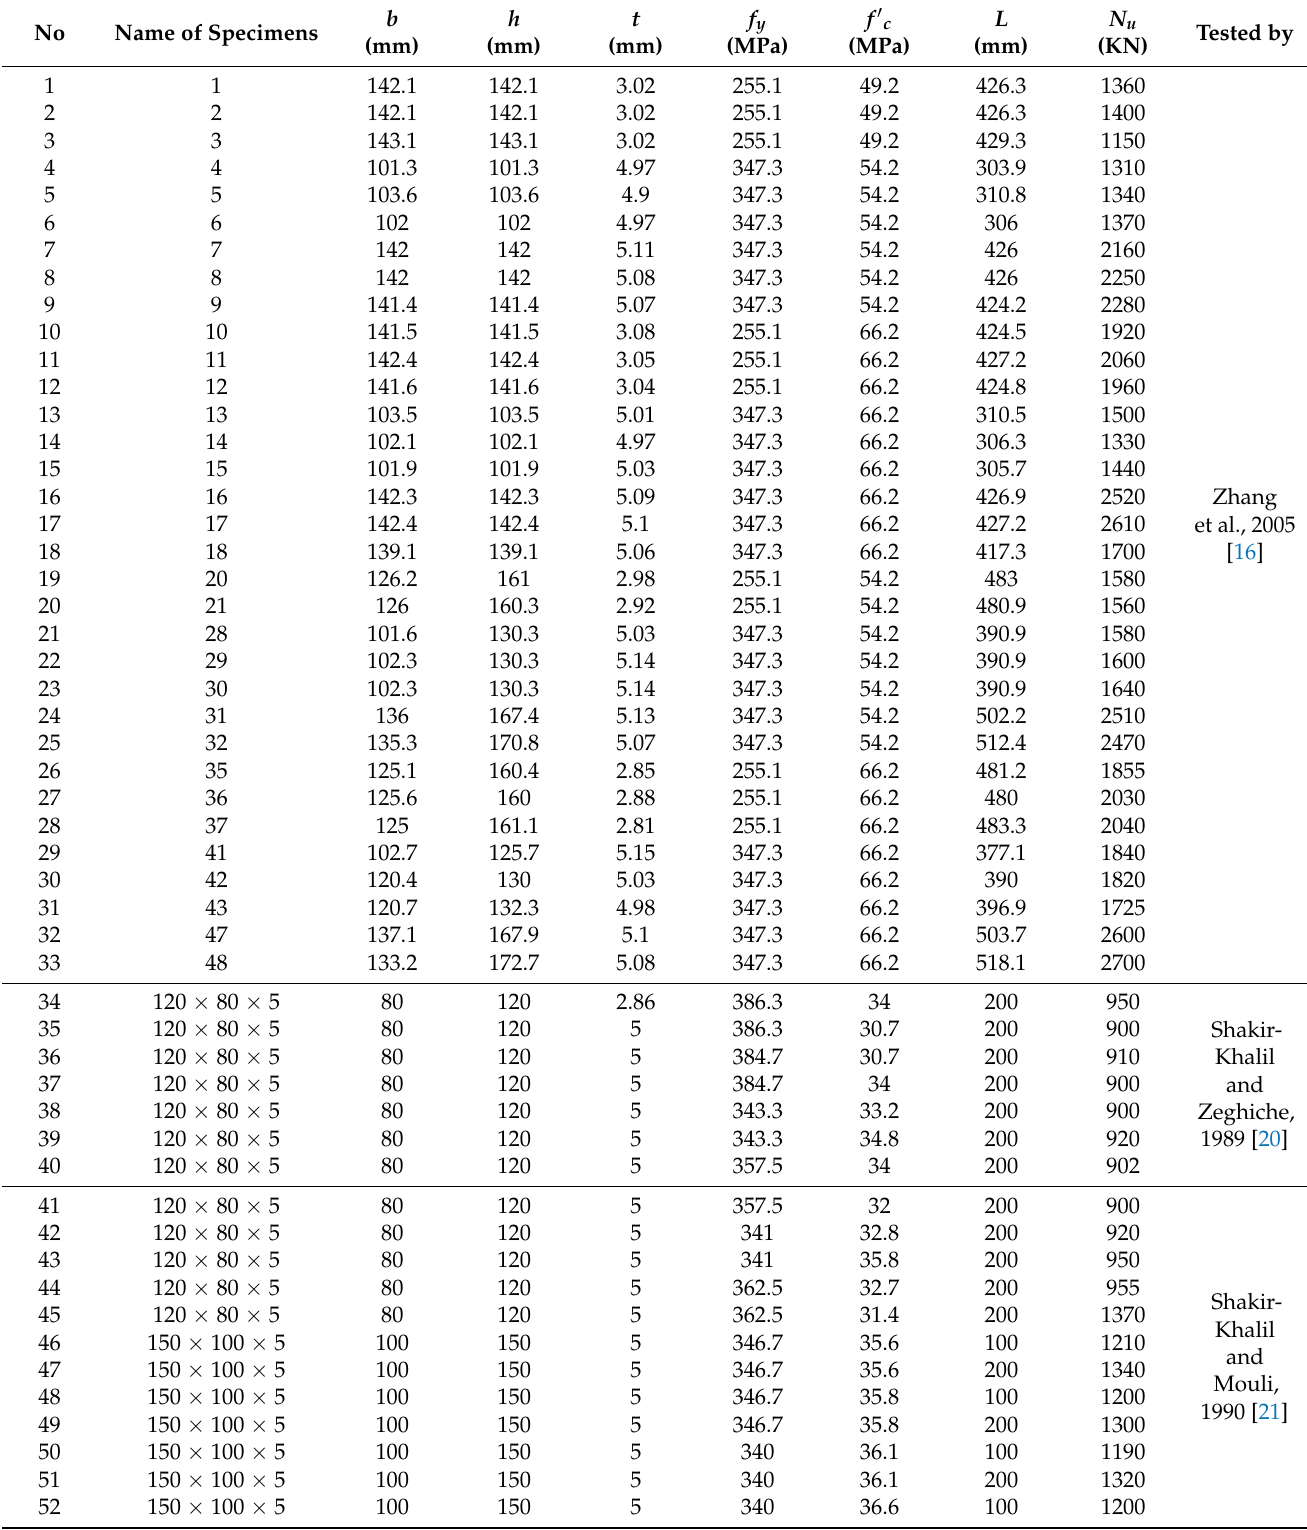
Table A1. Summary of the collected